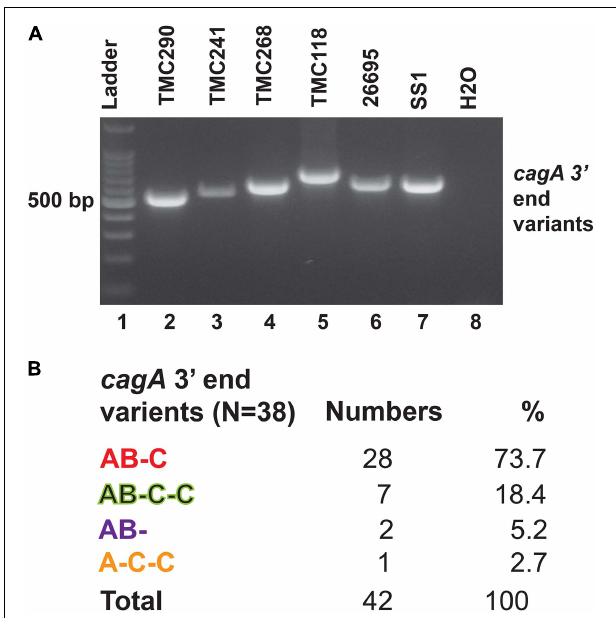
FIGURE 4 | (A) PCR targeting the 3 (cid:48) end variable regions of the cagA gene that encodes the EPIYA motifs. The amplicon sizes varied due to the variable number of EPIYA motifs and the spacer regions. (B) Different types of CagA types and their prevalence in Trivandrum. The nucleotide sequences (GenBank accession numbers MN968513 to MN968550) of the cagA genes were converted to the amino acid sequences and